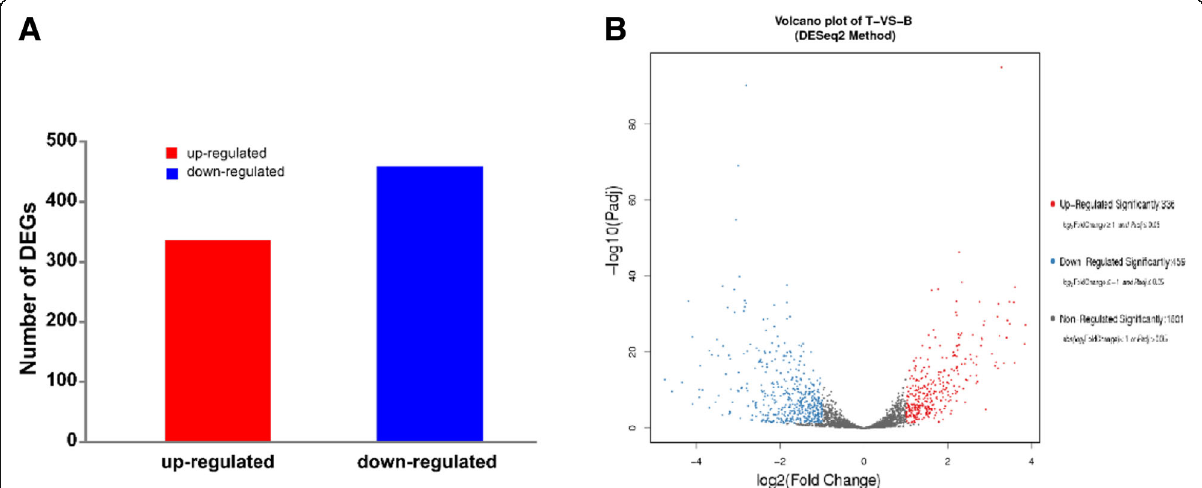
Fig. 4 Differentially expressed genes in berberine group compared to TSB control group. a Totally 795 significantly differentially expressed genes were detected, of which 336 were up-regulated and 459 were down-regulated (Significance: log2 Fold-change ≥ 1 and P -value < 0.05). b Volcano- plot map of 2596 detectable differentially expressed genes Red: significantly up-regulated genes; blue: significantly down-regulated genes, grey: non- significantly regulated genes (log2 Fold-change < 1 or P -value> 0.05). Wells containing 1% DMSO and bacteria was the bacterial growth control (GC)